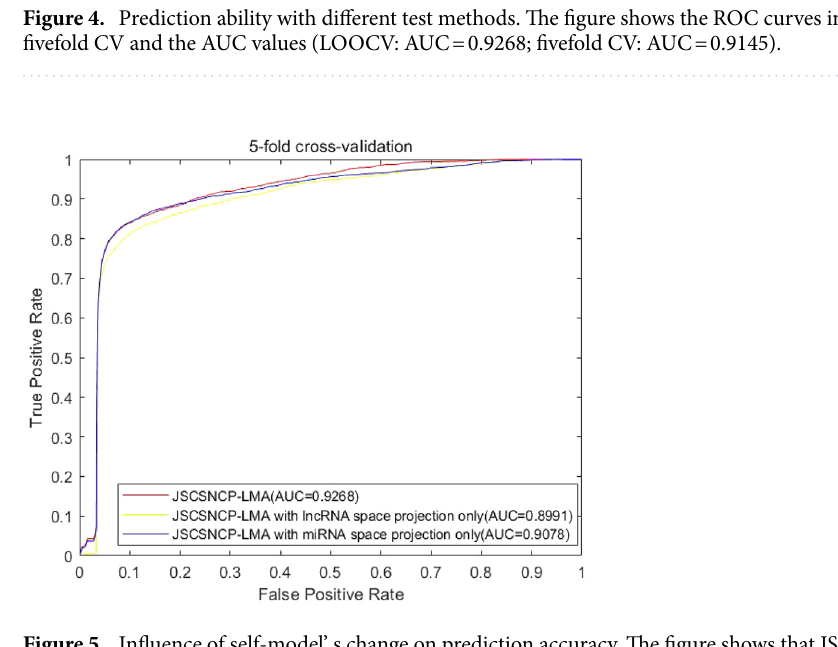
Figure 5. Influence of self-model’ s change on prediction accuracy. The figure shows that JSCSNCP-LMA has a reliable predictive performance with an AUC value of 0.9268. In the lncRNA projection space, the AUC value of JSCSNCP-LMA reach 0.8991. In the miRNA projection space, the AUC value is 0.9078. If the projection of two spaces is integrated, then the prediction performance can be greatly improved. Therefore, the JSCSNCP-LMA is reliable and has achieved good performance.